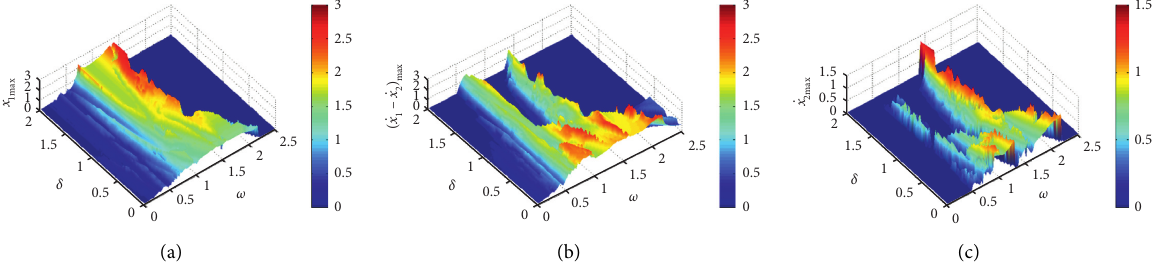
Figure 27: Local enlargement of Figure 26(b).